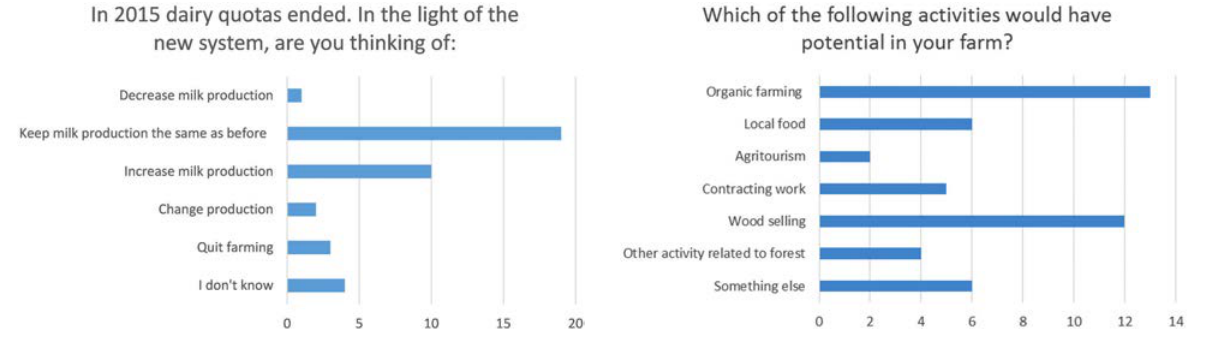
Fig. 6. Dairy farmers’ plans in the light of the end of Fig. 7. Potential activities that farmers could EU quotas. undertake in their farming beyond basic production.